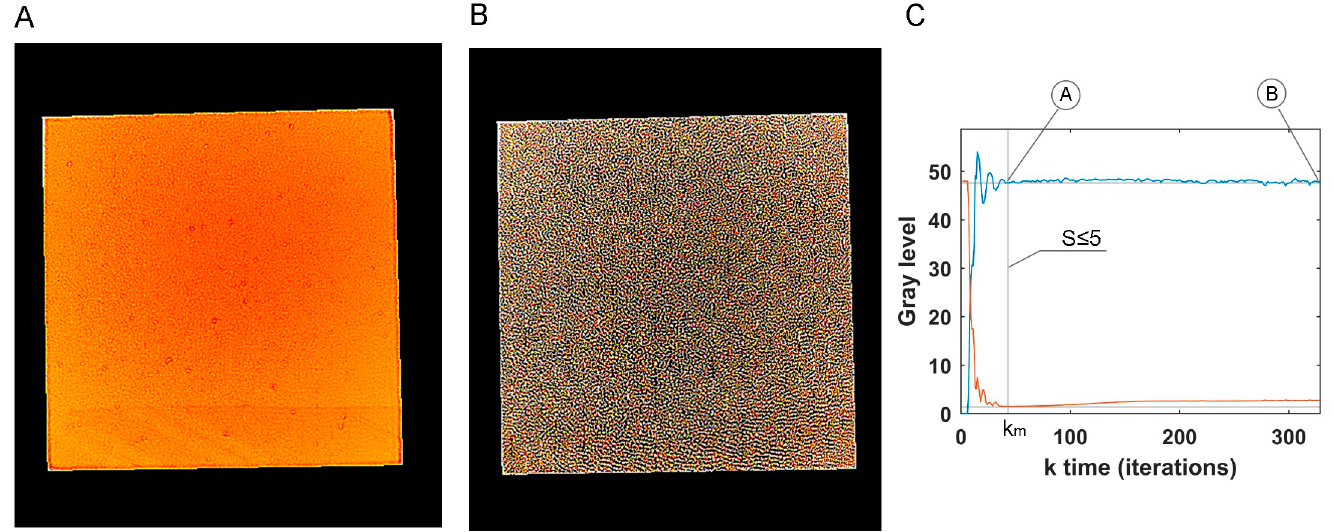
Fig 5. Stop control. (A) and (B) are the light patterns used as the control signal at different k instants when the error came close to zero, but (A) is the first one to reach it, and (B) is 283 iterations later. (C) Shows the output (blue) which is the grey level mean of image and control error to get reference.